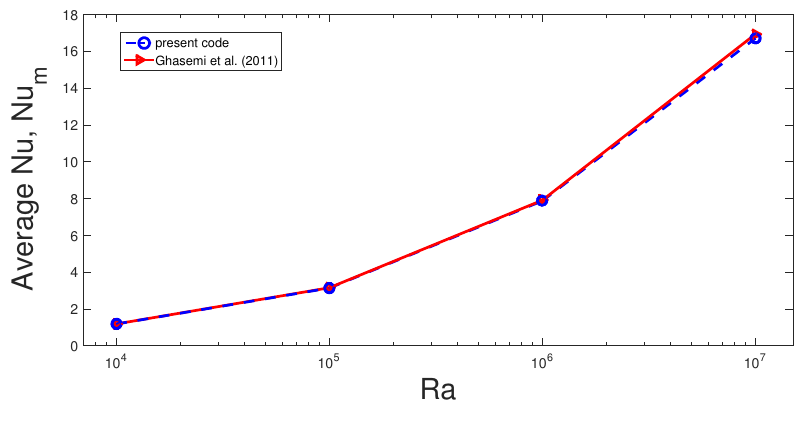
Figure 4. Code validation 1: comparisons of the average Nu for different Rayleigh numbers at a Hartmann number of 30. Results presented in [55] were